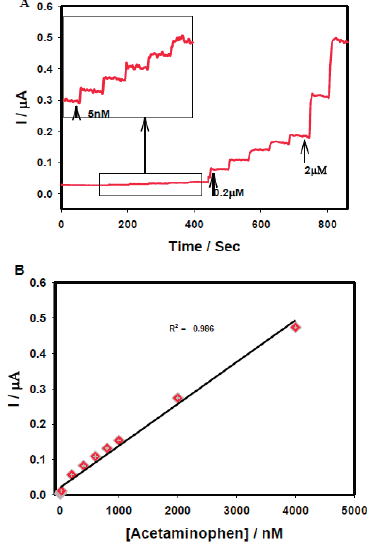
Figure 4. ( A ) Amperometric responses recorded at rGO/GCE in 0.1 M PBS under various acetaminophen concentrations (5 nM–4 µM), E app : 0.5 V and ( B ) the calibration plot of current vs acetaminophen concentrations. All figures are reproduced with permission